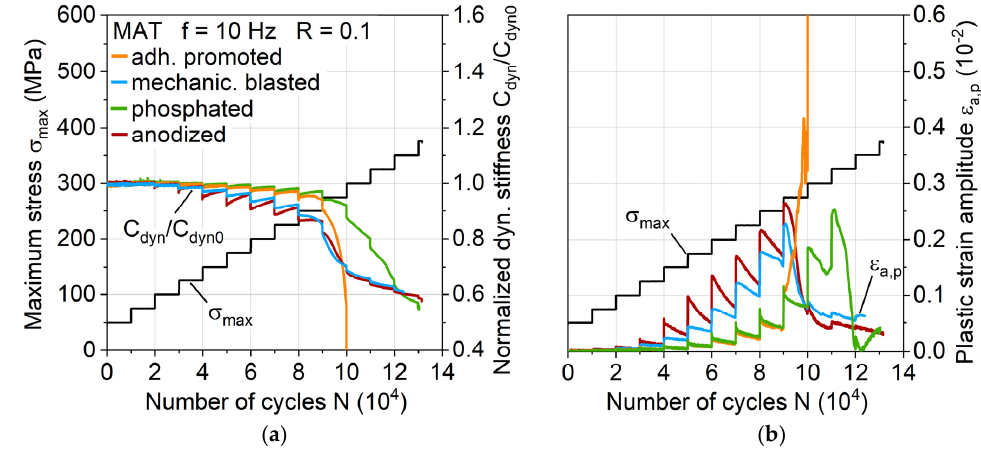
Figure 10. Influence of aluminum surface treatment on ( a ) normalized dynamic stiffness and ( b ) plastic strain amplitude during multiple amplitude tests.